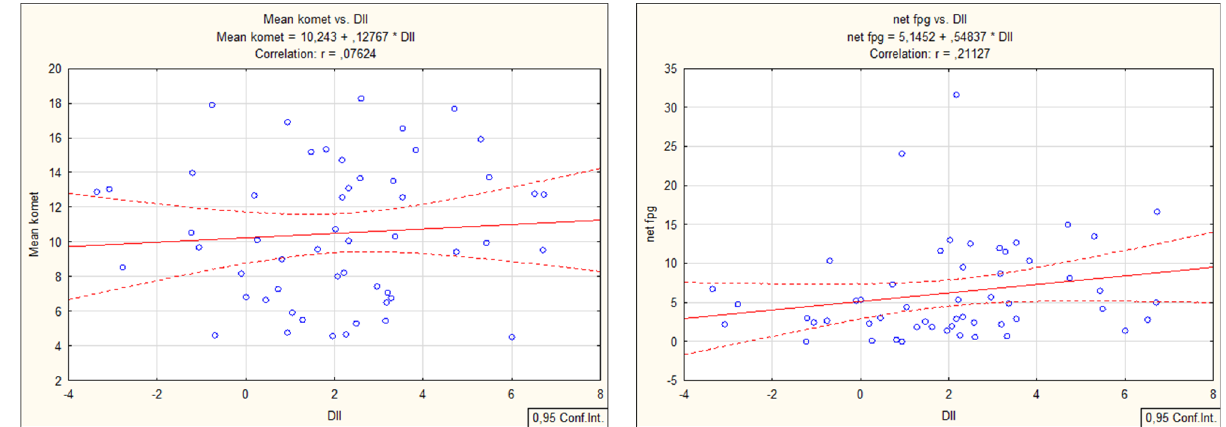
Figure 2. Spearman correlations of TI (%DNA in comet tail) in comet assay (no significant correlation) and Fpg comet assay with inflammatory food index DII.